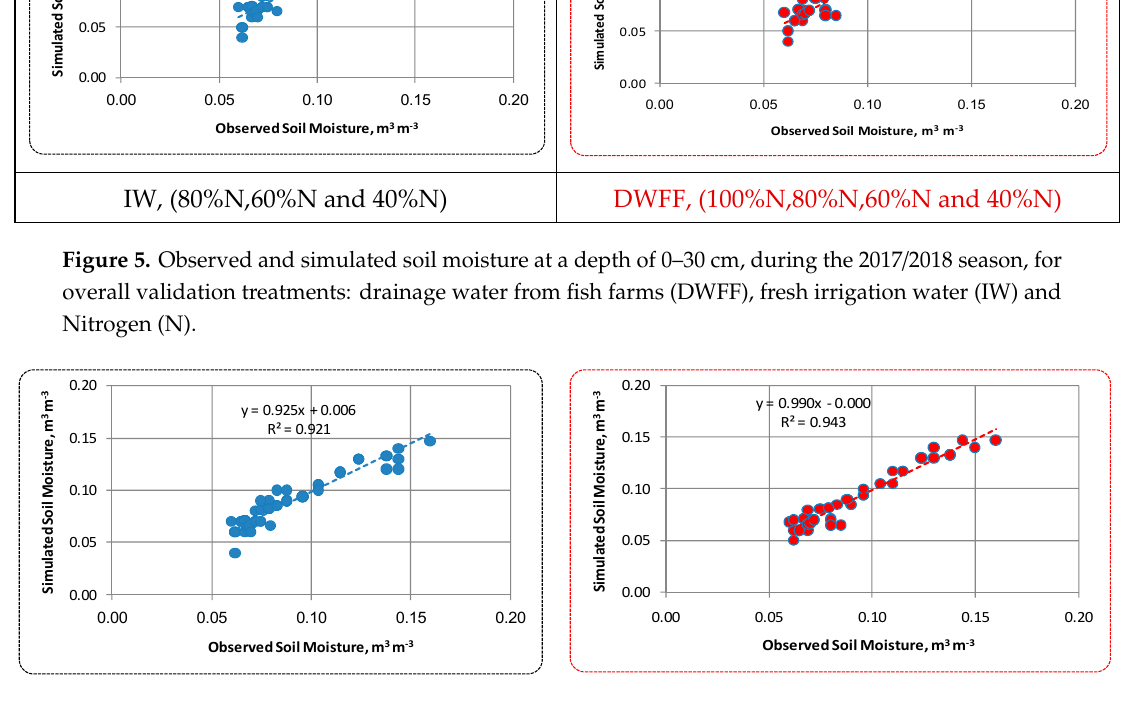
Figure 6. Observed and simulated soil moisture at a depth of 0–30 cm depth, during the 2018/2019 season, for overall validation treatments: drainage water of fish farms (DWFF), fresh irrigation water (IW), and Nitrogen (N).